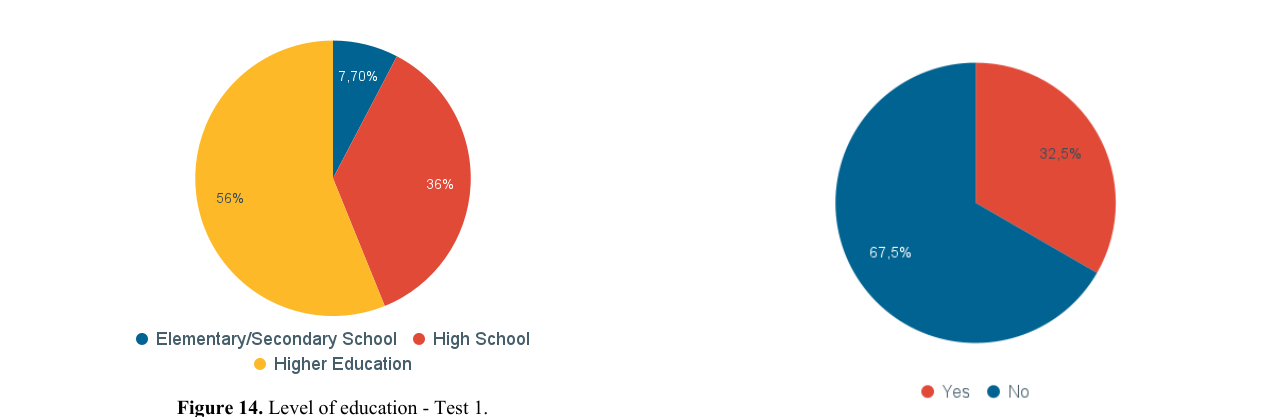
Figure 14. Level of education - Test 1.